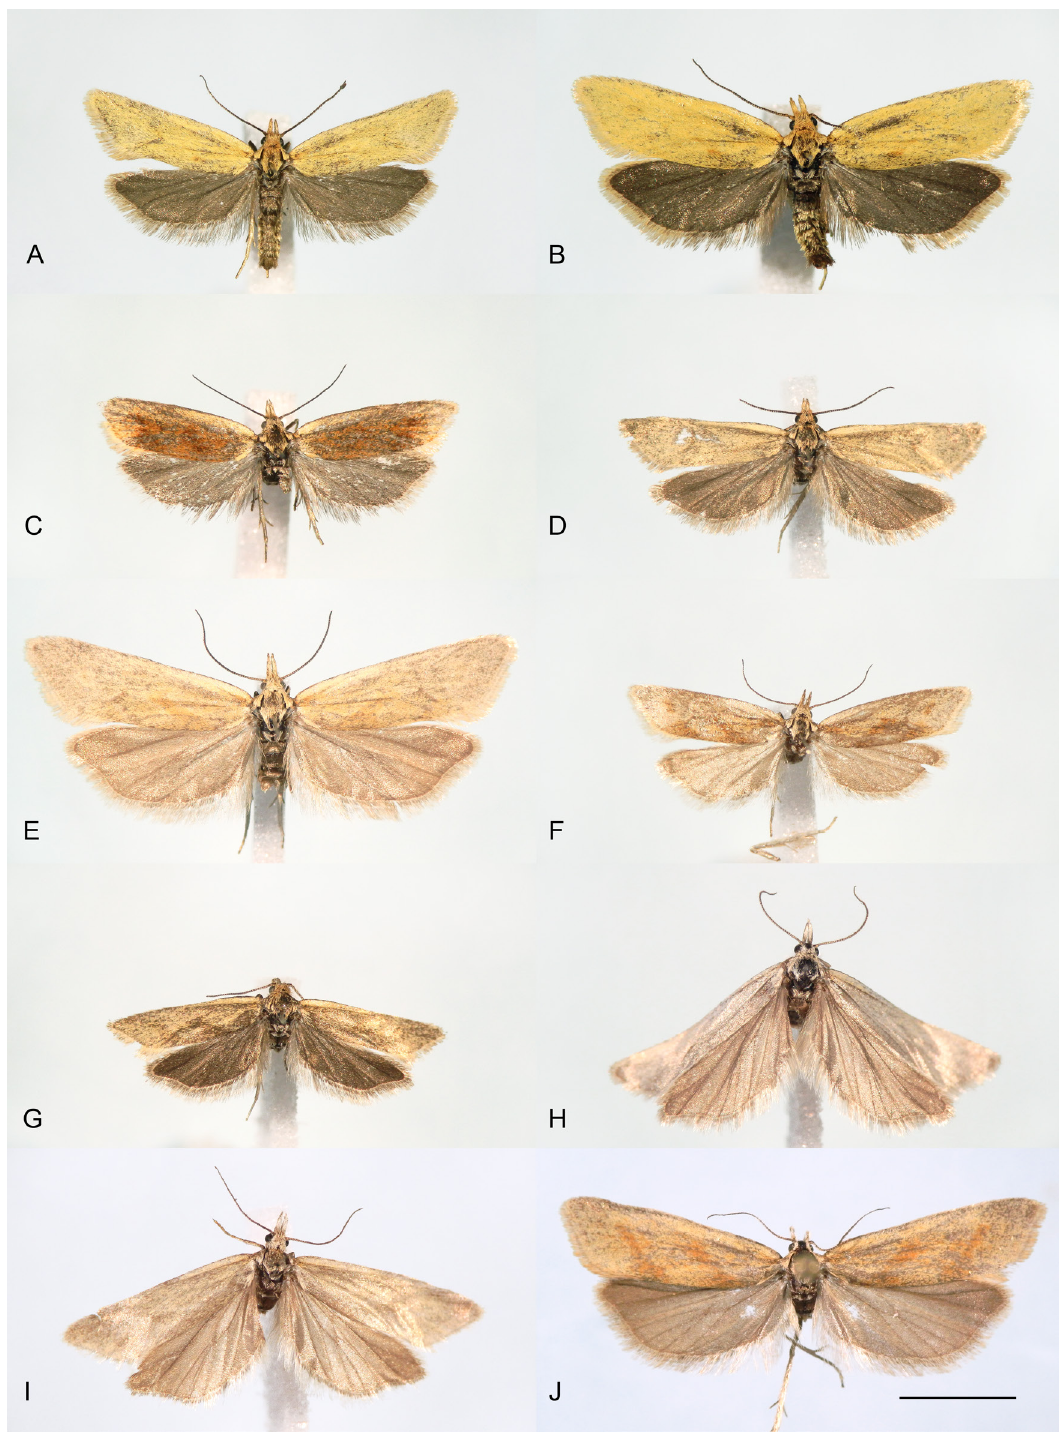
Fig. 1. Adults of Phtheochroa spp. A–D . P. schawerdae (Rebel, 1908) comb. nov. A . ♂, Bulgaria,